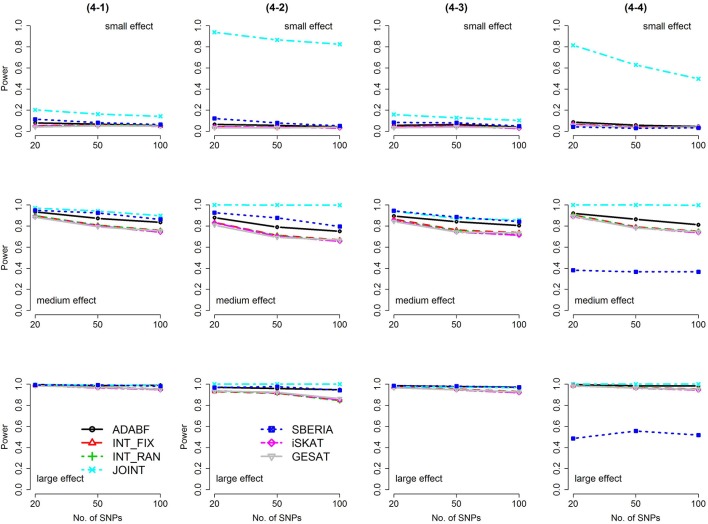
Power of the seven tests for binary traits (4 SNP × E, from Scenario 4-1 to 4-4). The x-axis represents the number of SNPs in the gene, whereas the y-axis depicts the power at the nominal significance level α = 2.5 × 10−6. From the top row to the bottom row, the magnitudes of SNP main effects and SNP × E interaction effects were evaluated at three levels: small, medium, and large, respectively.